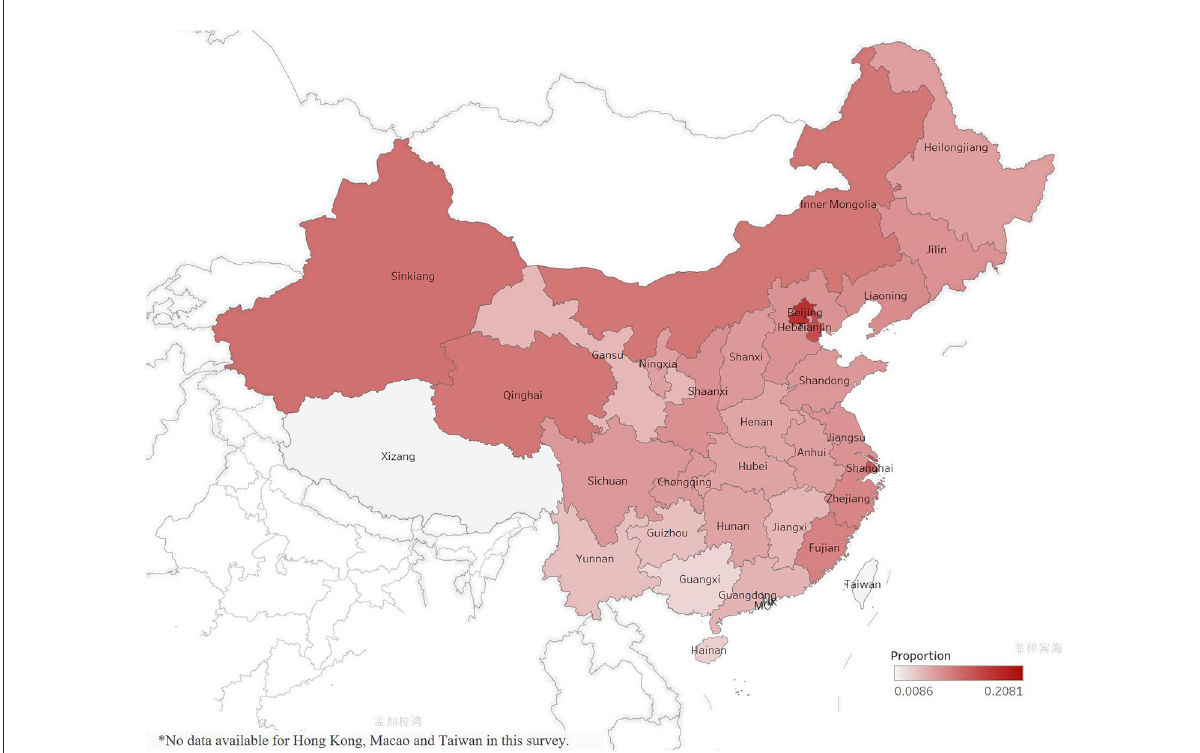
FIGURE2 Geographic distribution of diabetes prevalence in 31 selected provinces/municipalities in the fourth SSAPUR study. Hong Kong, Macao and Taiwan were not included in this survey.